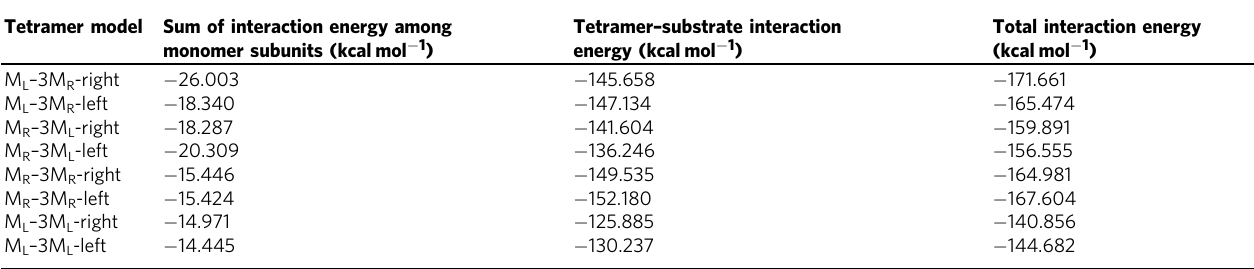
Table 1 Calculated interaction energies of valinomycin tetramer on the Cu(111) surface by DFT simulations Tetramer model Sum of interaction energy among monomer subunits (kcal mol − 1 )